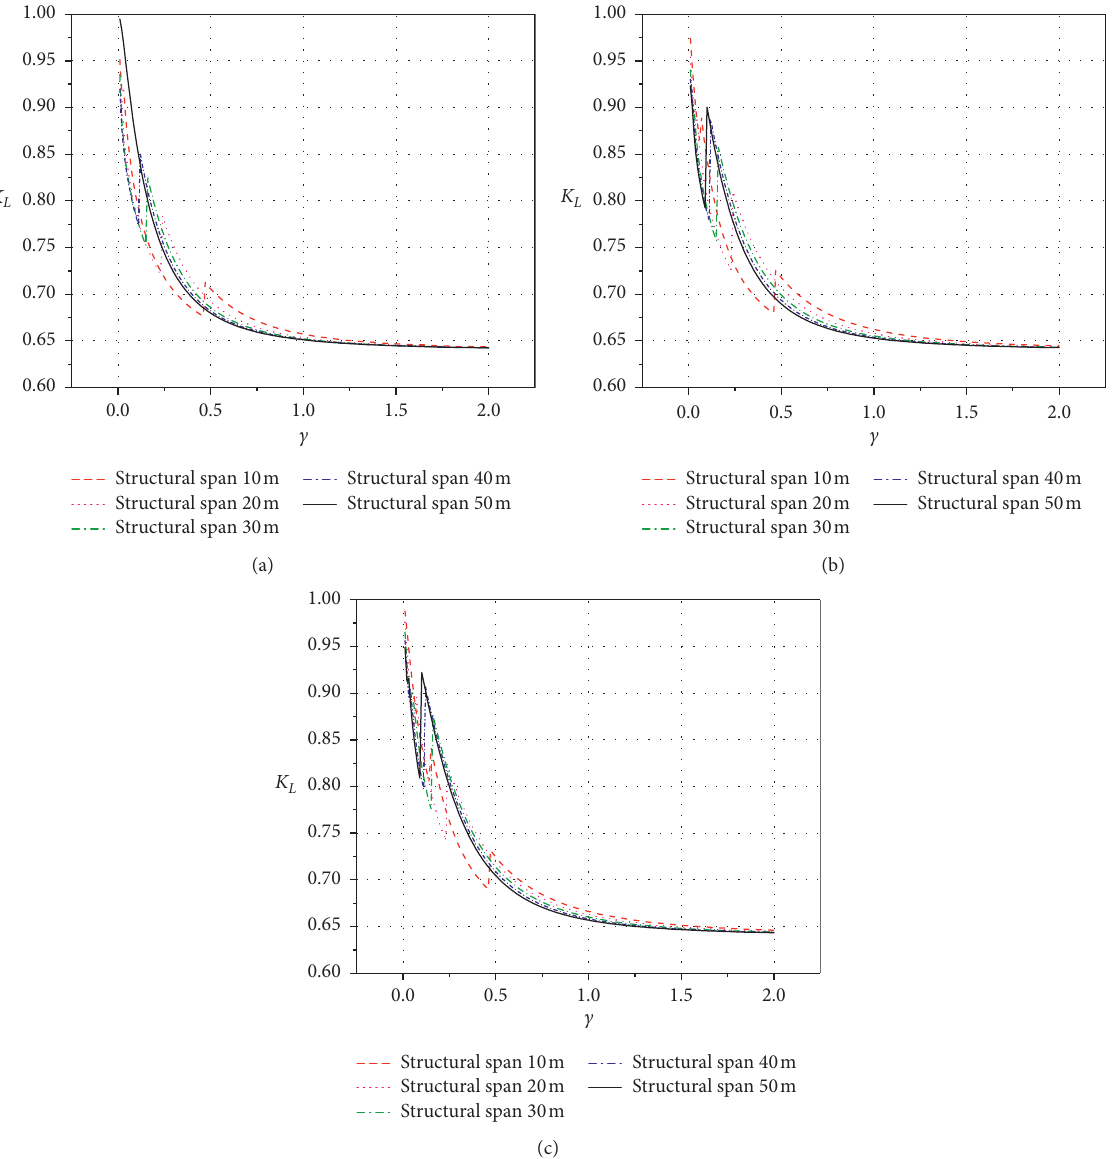
Figure 4: Equivalent load transformation factors of simply supported one-way members using Henrych’s formula parameters. (a) W � 1kg. (b) W � 10kg. (c) W �